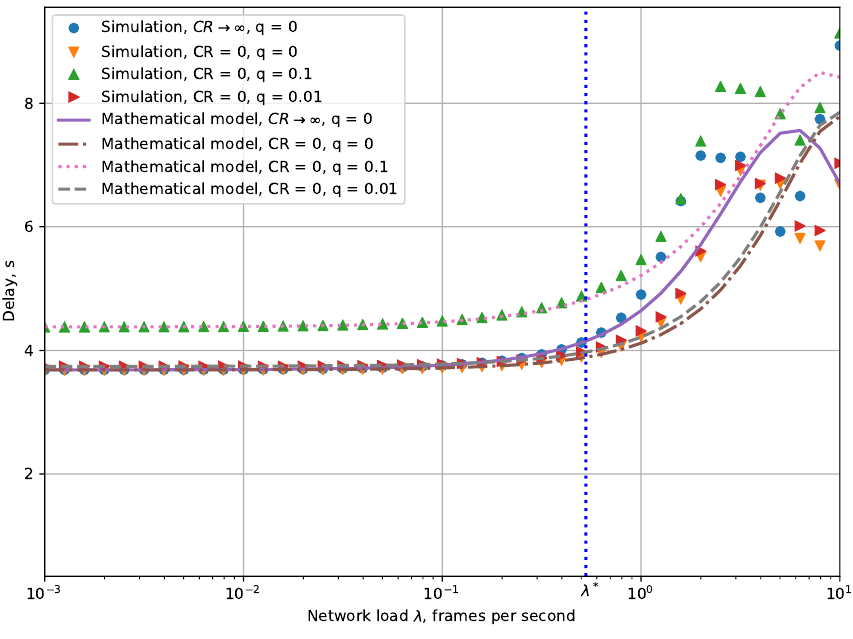
Figure 7. Dependency of the packet delivery time on the network load.